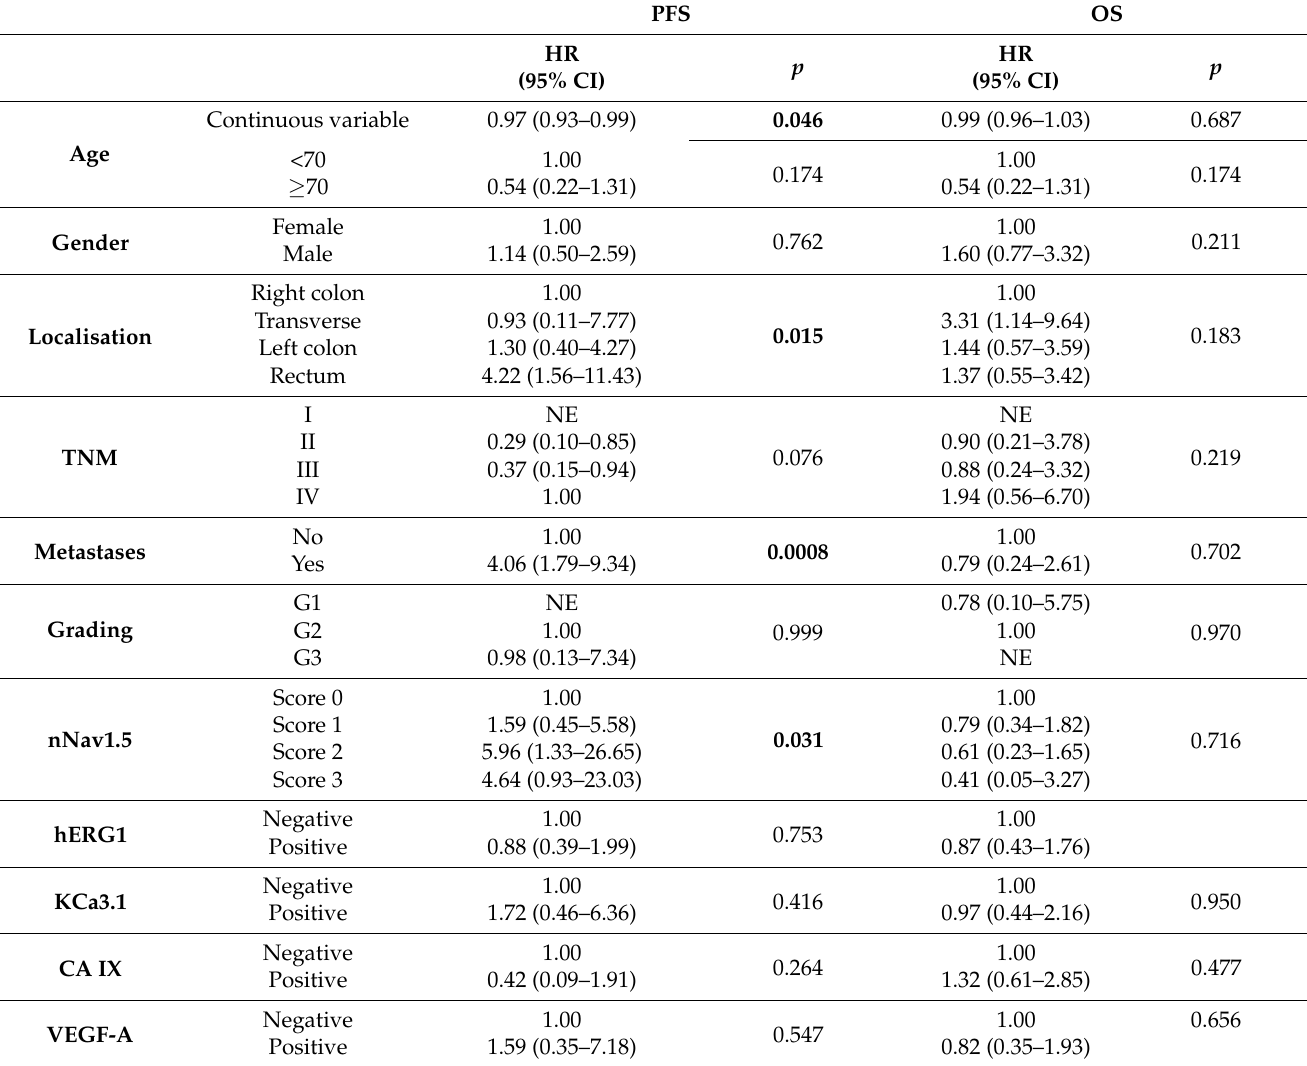
Table 3. Results of PFS and OS univariate analysis for clinical and biomolecular parameters (log-rank test and Mantel Cox test). Statistically significant associations ( p < 0.05) are highlighted in bold. NE = Not